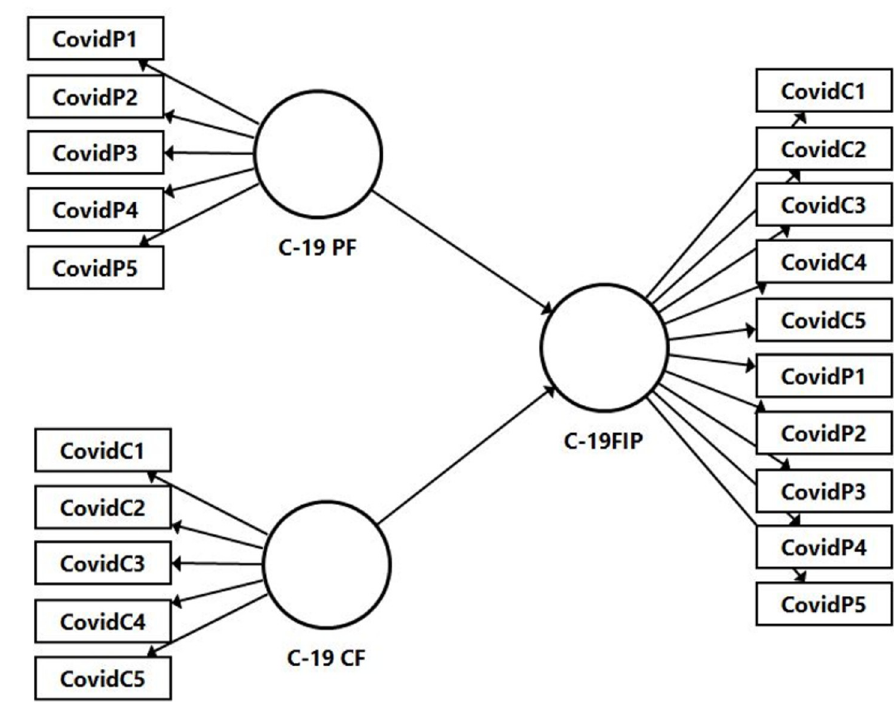
Fig 2. Reflective-formative second order model.